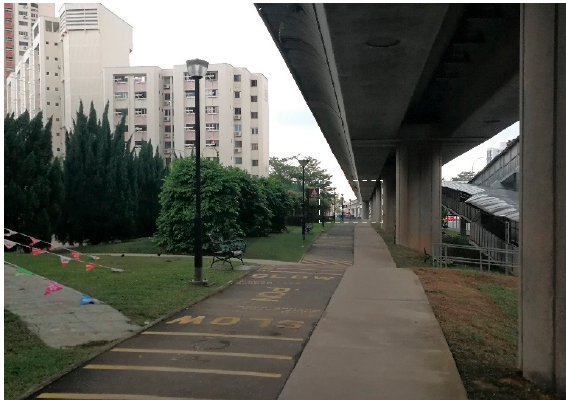
Figure 4 . A running/cycling track and Chinese Garden MRT station in the distance. Figure 4. A running / cycling track and Chinese Garden MRT station in the